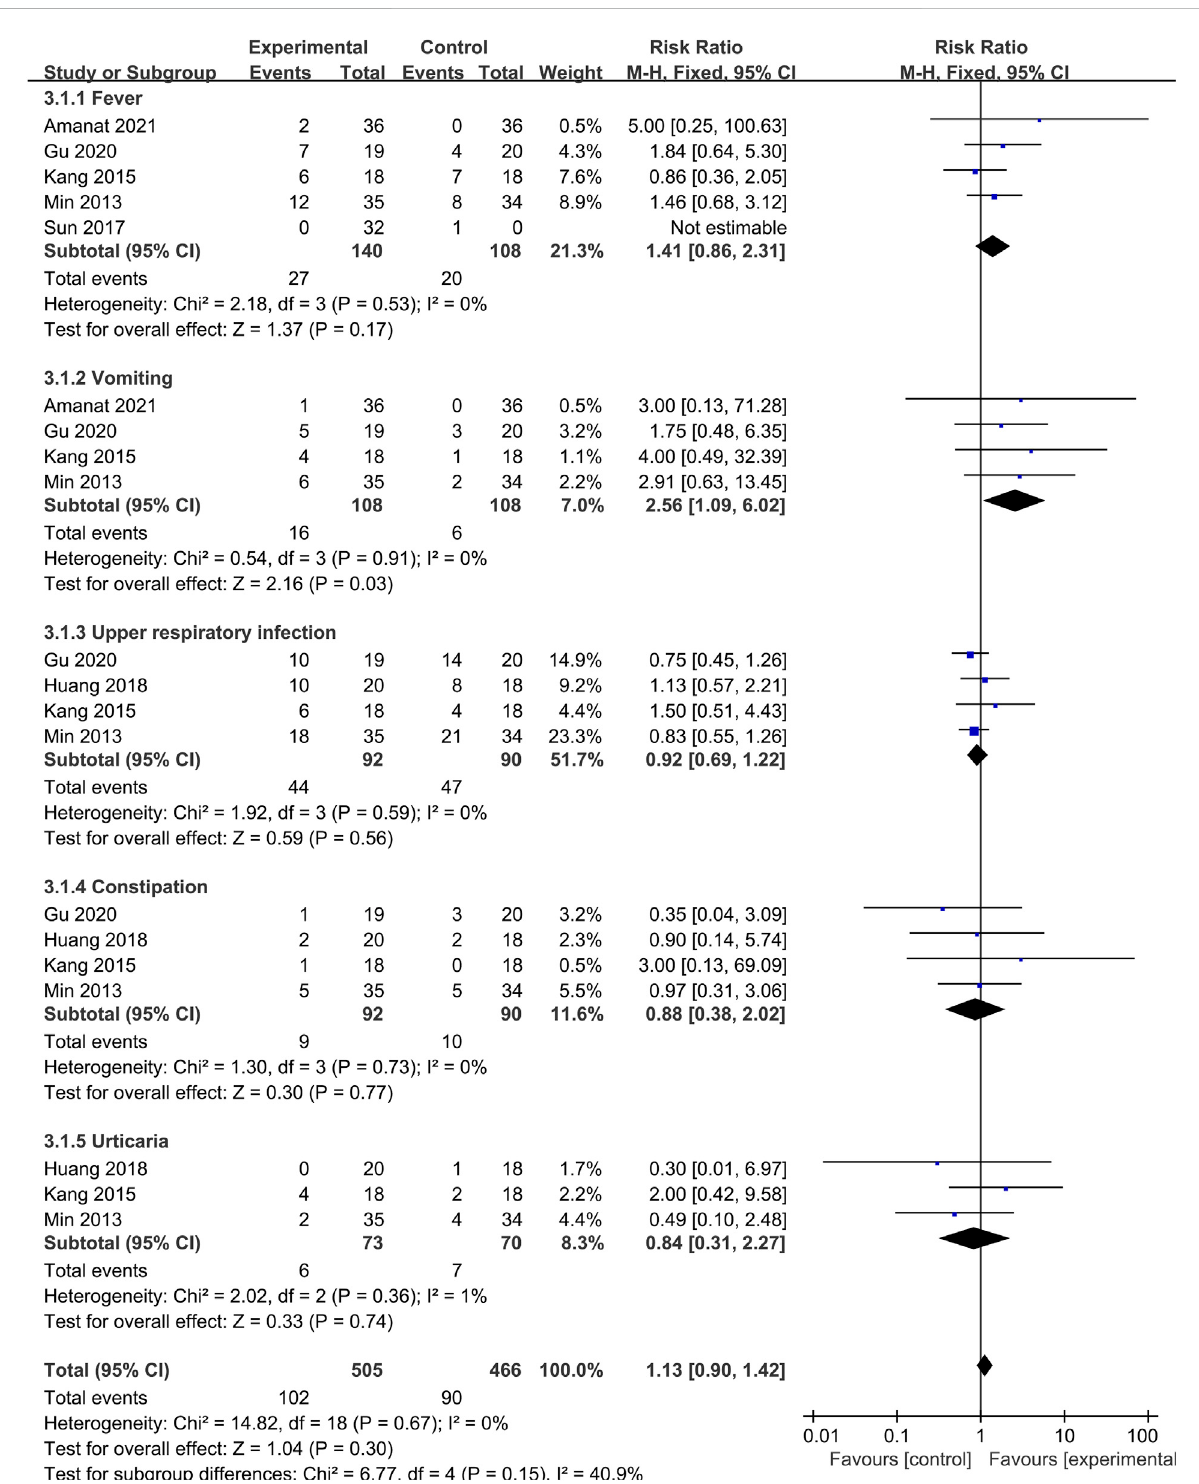
Forest plot of adverse